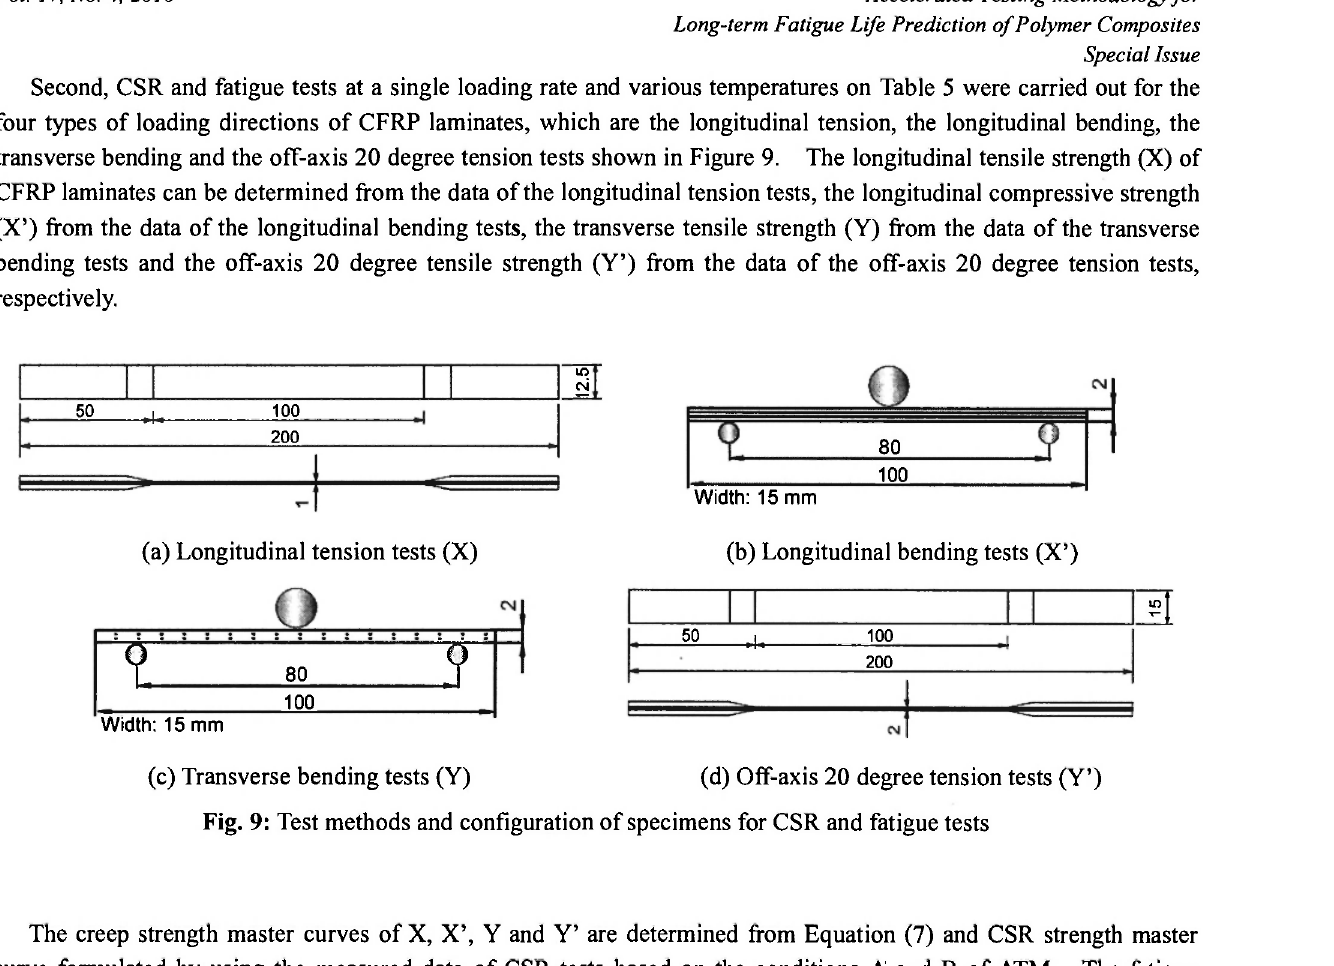
Fig. 9: Test methods and configuration of specimens for CSR and fatigue